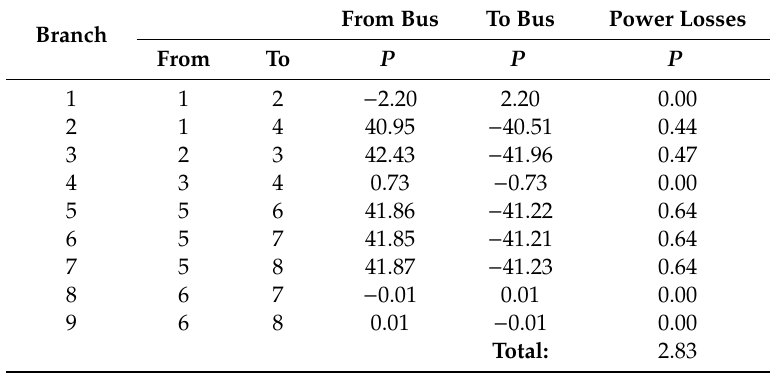
Table A49. Results of the mixed AC / DC PF calculations in Case 7-5. DC branch